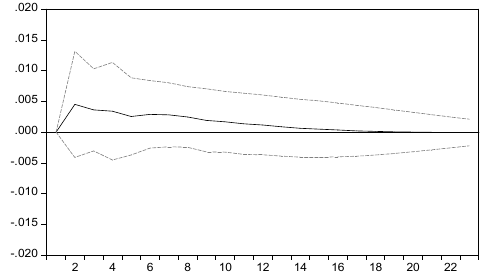
Figure 2. Response of ERATE to CONFI